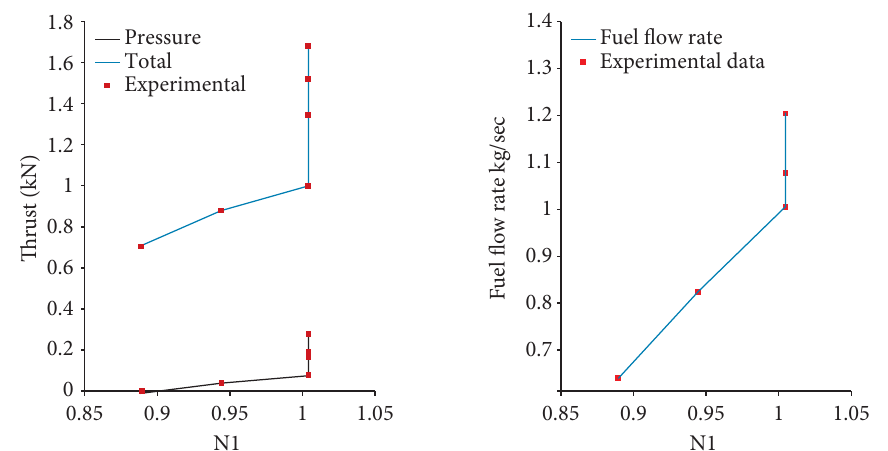
Figure 16. Major performance parameters from simulation, validated with test bed data. Total thrust refers to summation of pressure and momentum thrust, obtained from simulation.